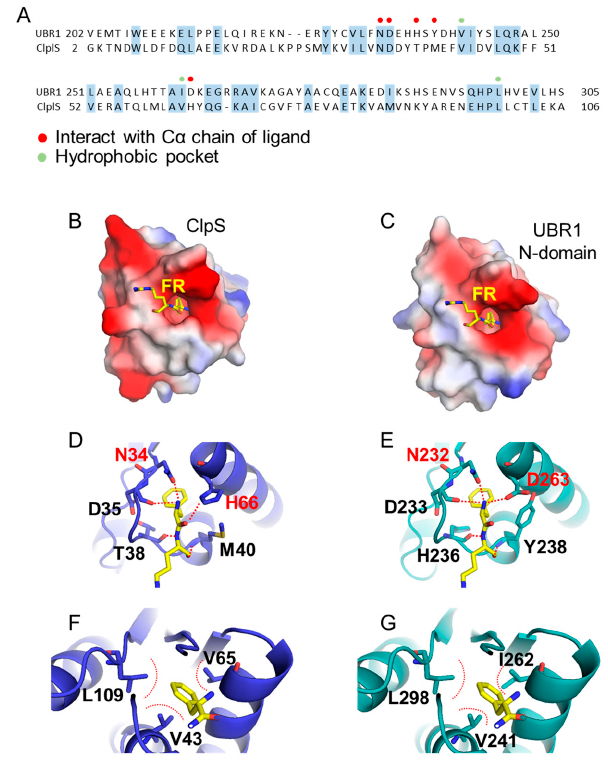
Figure 6. Homology models of the human UBR1 N-domain based on ClpS of Escherichia coli . The homology model of the N-domain of human UBR1 was generated based on the ClpS structure (PDB ID 2W9R) using the SWISS-MODEL program [65,66] . ( A ) The amino acid sequences of human UBR1 and E. coli ClpS are aligned. Conserved residues are highlighted with light blue boxes. Red and light green dots indicate the residues recognizing type 2 N-degrons. ( B , C ) The surface models of the ClpS and N-domain are colored by charge. The ligand, Phe–Arg peptide, is represented as a stick. ( D , E ) The residues constituting the entrance of the hydrophobic pocket interact with the backbone of the first amino acid (Phe) by charge–charge interactions and hydrogen bonding (red dotted lines). ( F , G ) The hydrophobic residue of the first amino acid is bound to the hydrophobic pocket. The red dotted lines mark the space created by the hydrophobic residues constituting the